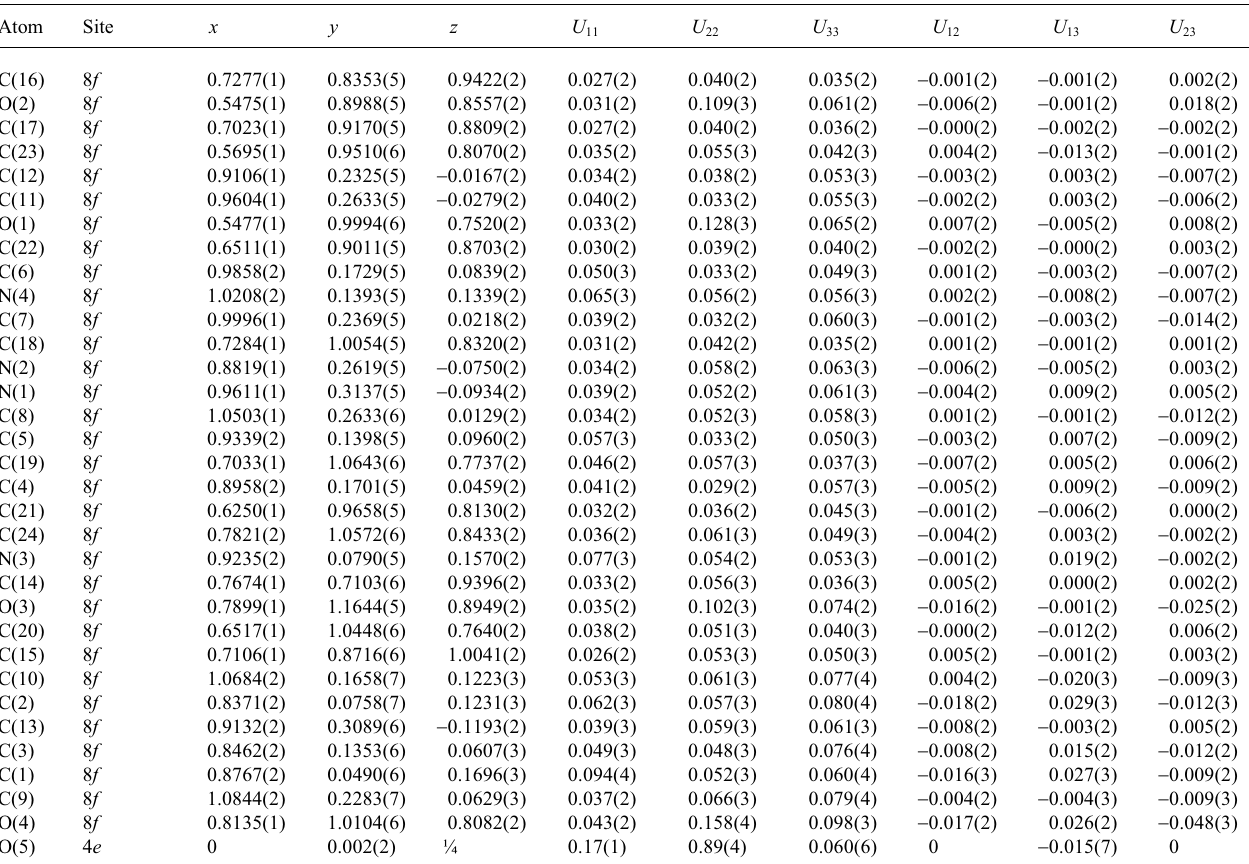
Table 3. Atomic coordinates and displacement parameters (in Å 2 )